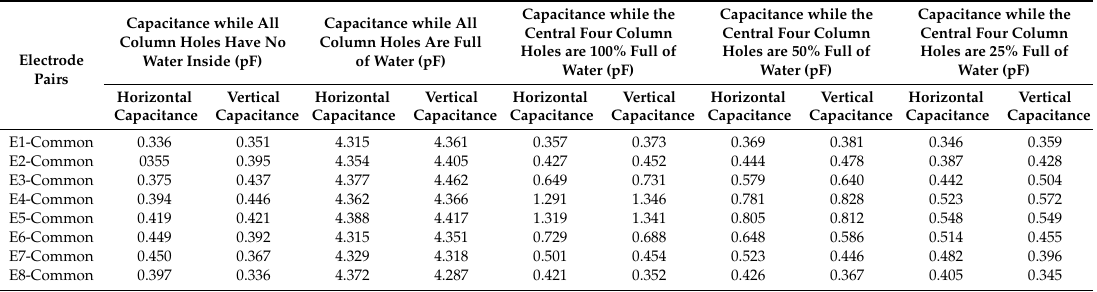
Figure 8. Plexiglass slab and capacitance sensor array used in experiment. ( a ) Top view of plexiglass slab, ( b ) top view of capacitance sensor array, ( c ) plexiglass slab covered with sensor array.